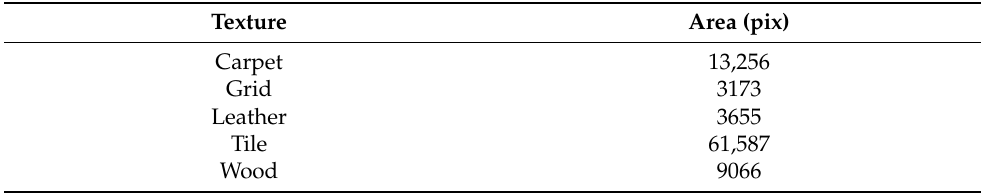
Table 5. Mean defect size in pixels for each texture.